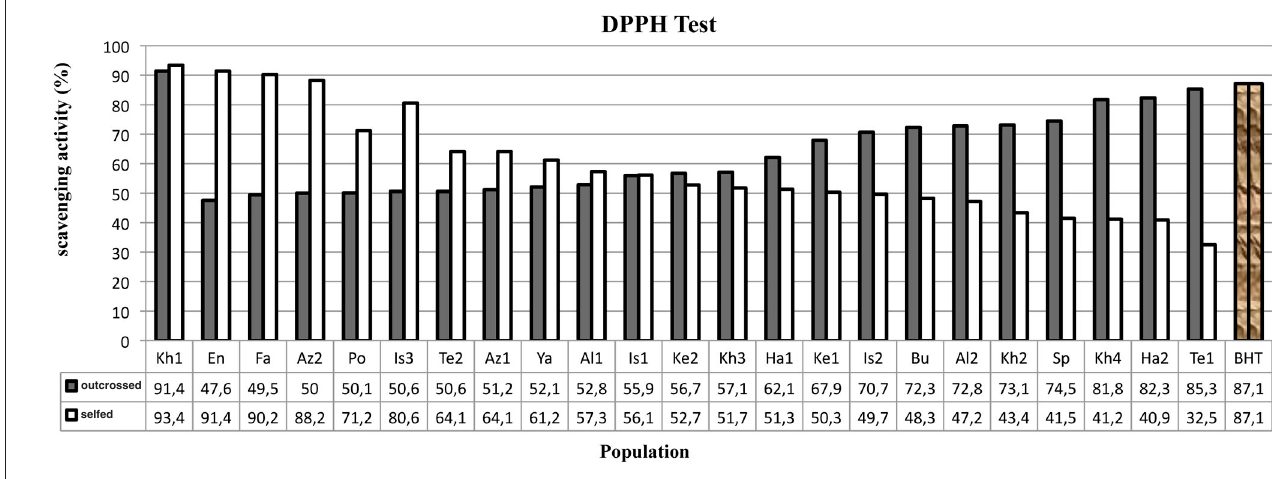
outcrossed Fig. 3: DPPH radical scavenging activity of outcross and self-pollinated population of fennel extracts compared to BHT.